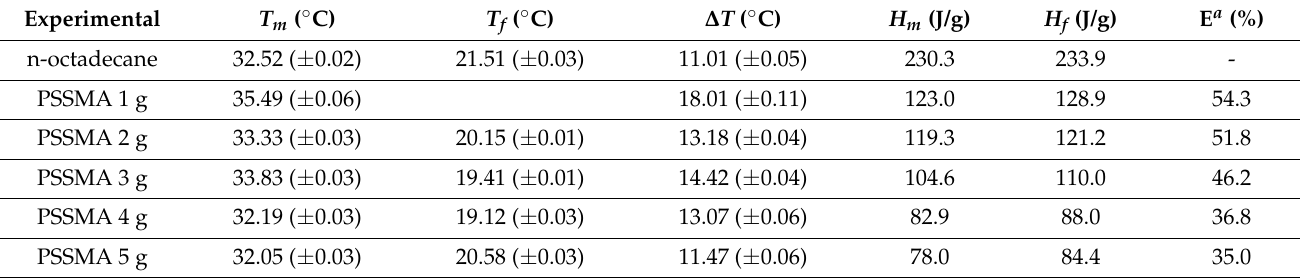
Figure 3. DSC curves of the PUA-NEPCMs with varying PSSMA contents. Table 2. Phase transition temperatures and corresponding latent heats of OD and the PUA-NEPCMs, in addition to the encapsulation efficiencies (E) of the